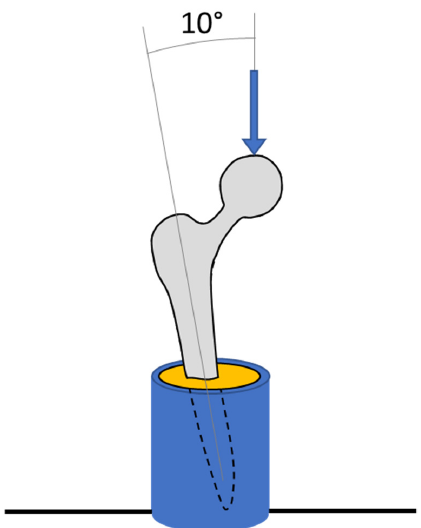
Figure 4. Diagram of experimental tests showing a hip implant (grey) secured in a metallic pot (blue) with PMMA (yellow).